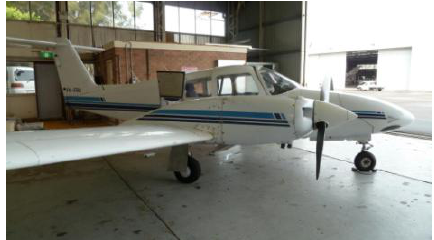
Figure 5. Light aircraft used for conducting the experiment.